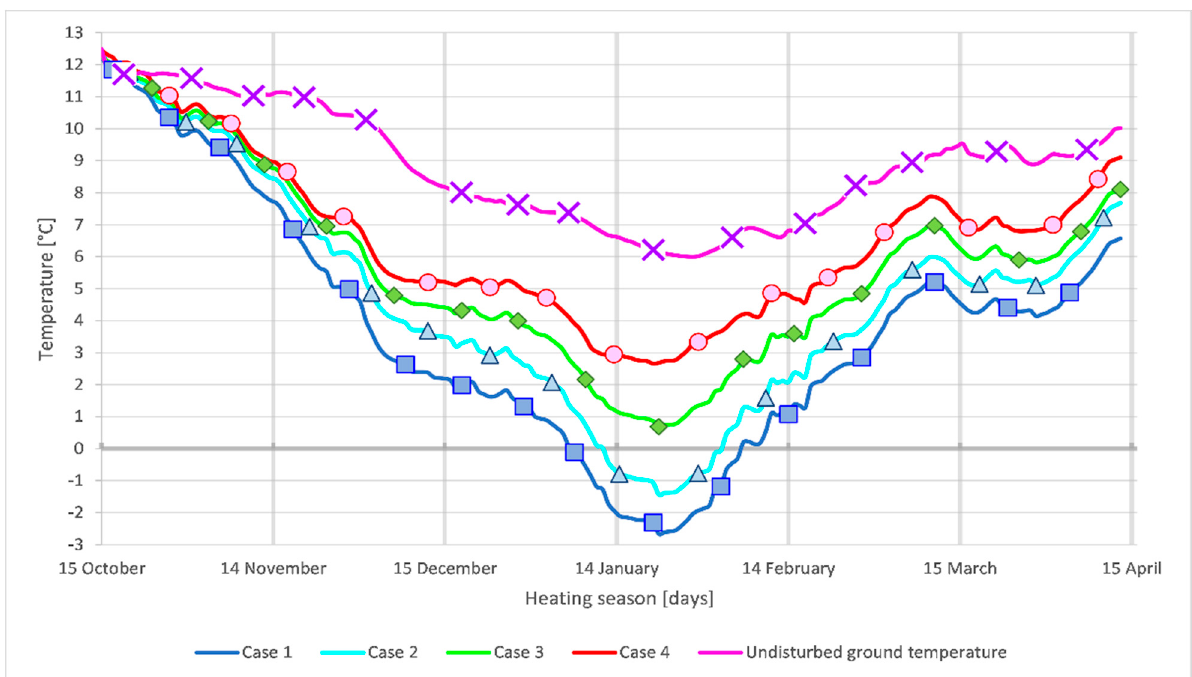
Figure 11. Mean temperature at pipe depth of 1.2 m for HGHE for each simulation case in relation to the measured undisturbed ground temperature.